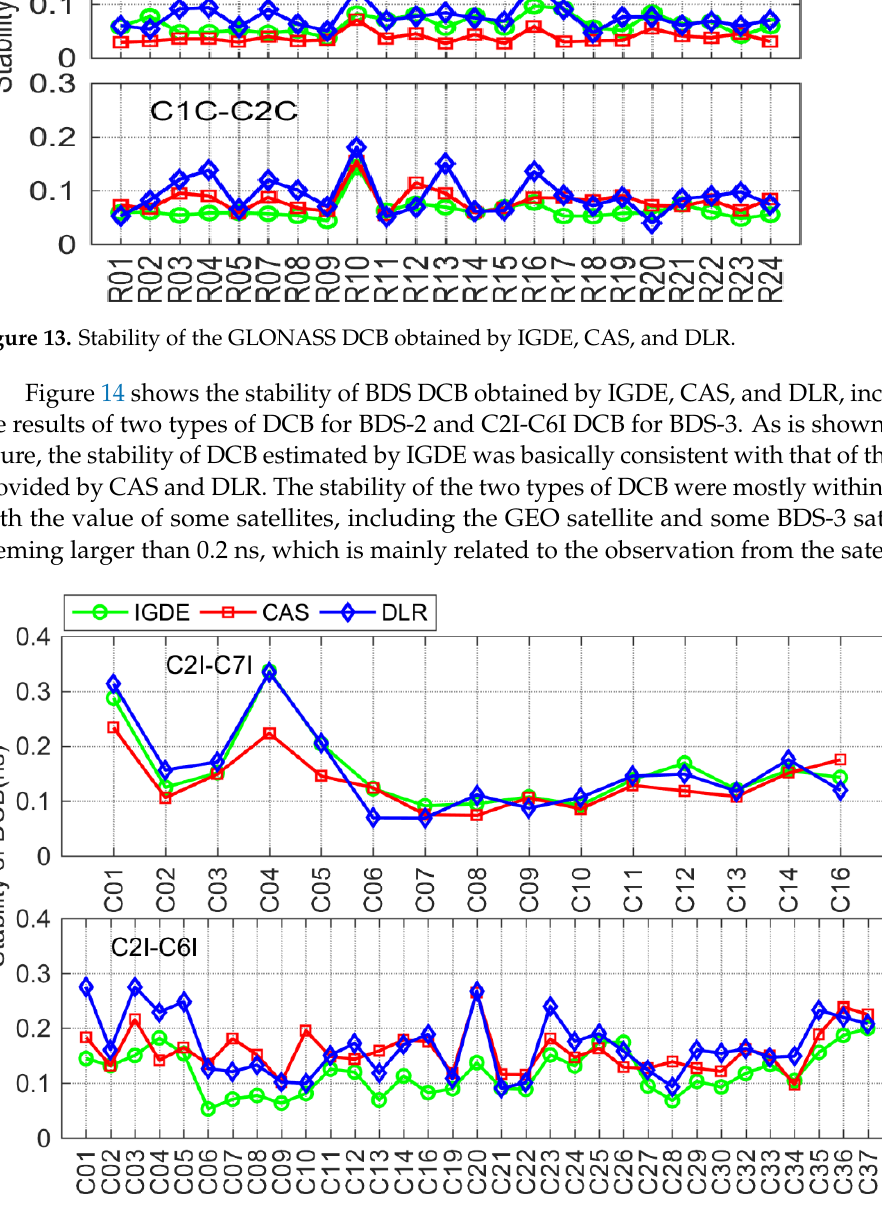
Figure 14. Stability of the BDS DCB obtained by IGDE, CAS, and DLR.